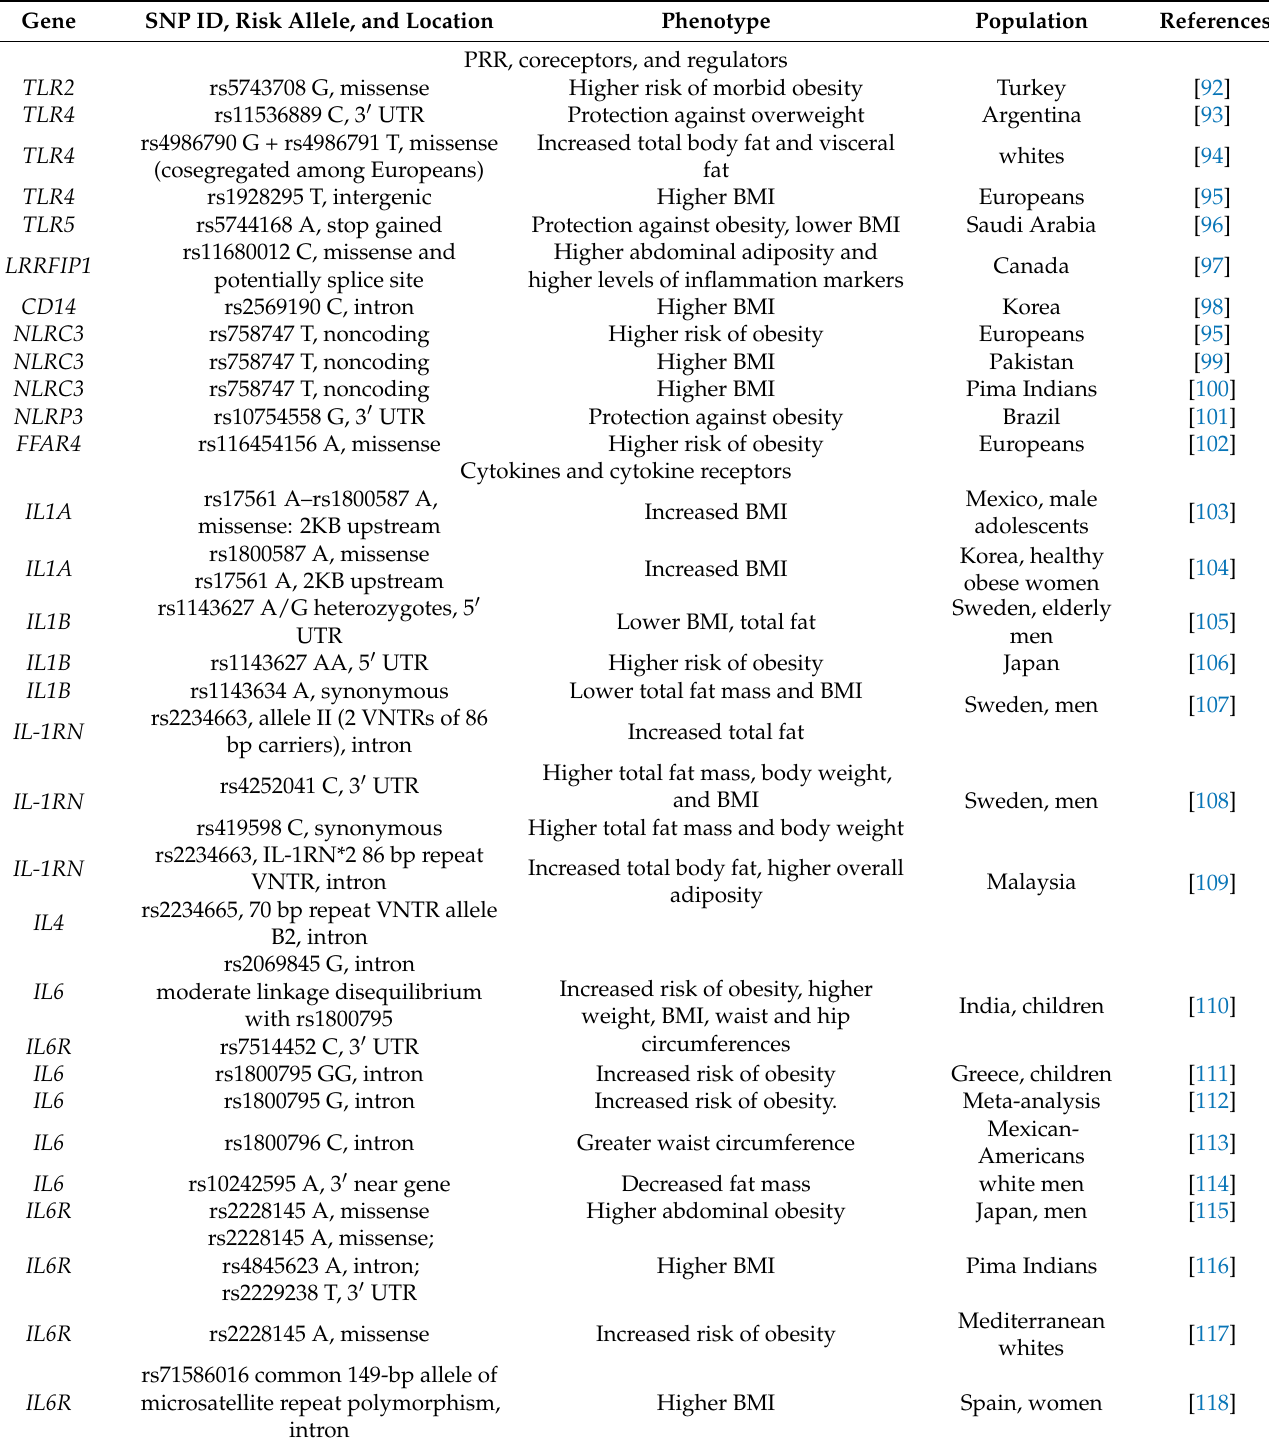
Table 2. Genetic variants of innate-immunity genes associated with obesity in humans. Risk allele designation is given in accordance with the dbSNP